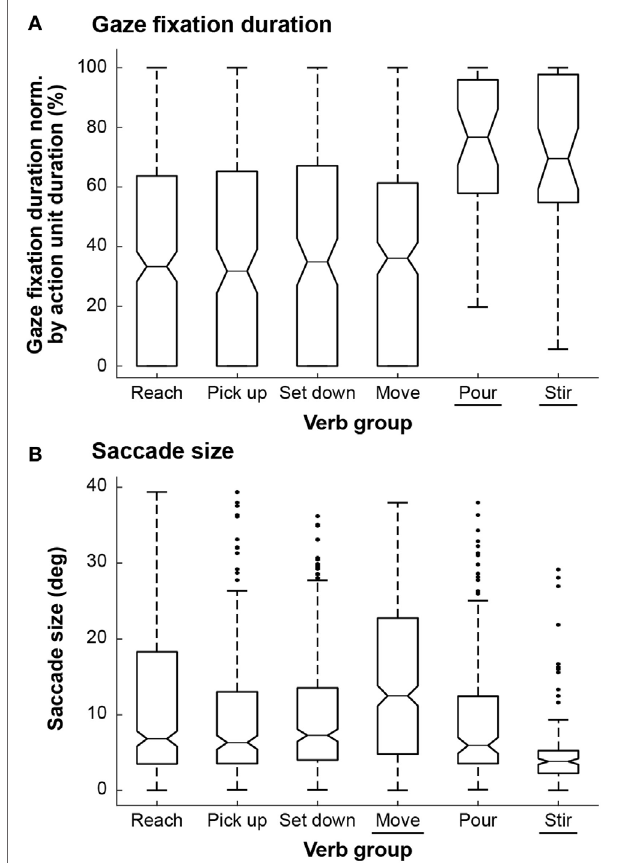
FigUre 4 | Box and whisker plots are shown for each of the six action unit verb groups for (a) normalized gaze fixation duration and (B) saccade size. The tapered neck of each box marks the median while the top and bottom edges mark the first and third quantiles. The whiskers extend to the most extreme data points that are not considered outliers (black dots). For normalized gaze fixation duration, both “pour” and “stir” were statistically significantly different from the other action unit verb groups, as indicated by underlines. For saccade size, both “move” and “stir” were statistically significantly different from the other action unit verb groups.